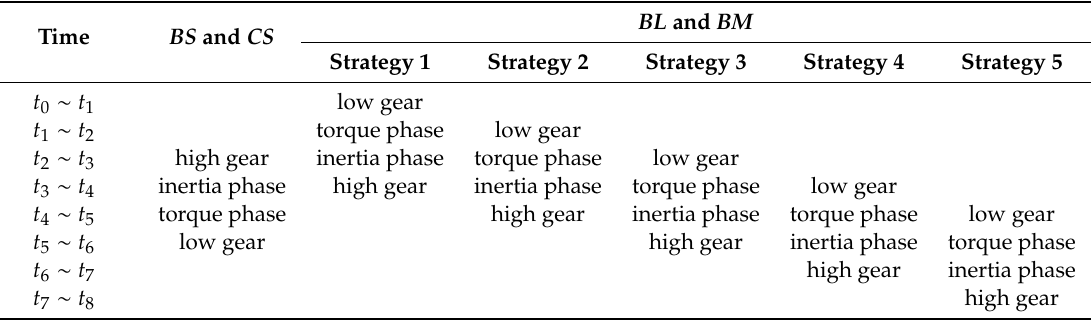
Table 2. Five control strategies for double-transition shift